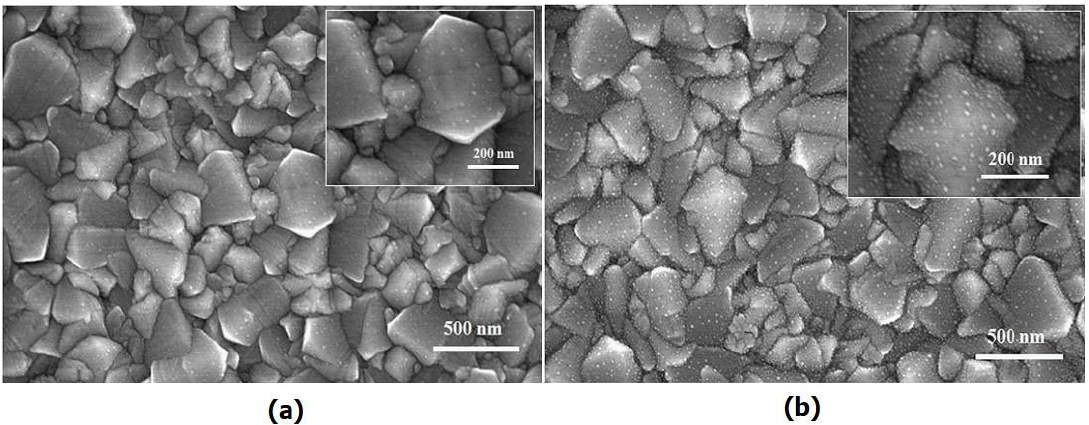
Figure 1. ( a ) High-Resolution Scanning Electron Microscopy (HRSEM) image of Ag-nanoparticles (NPs) on an fluorine-doped tin oxide (FTO) glass substrate; and ( b ) HRSEM image of Au-NPs on an FTO glass substrate.